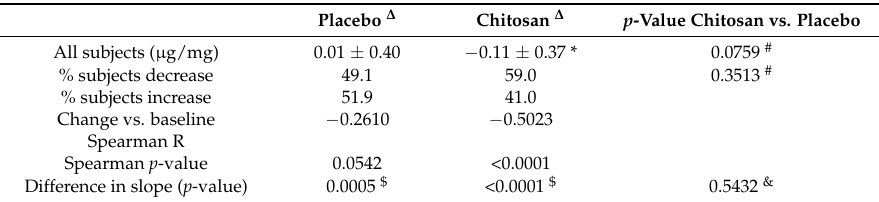
Table 10. Comparison of changes in serum total R_lathosterol induced by chitosan and placebo treatments. Placebo ∆